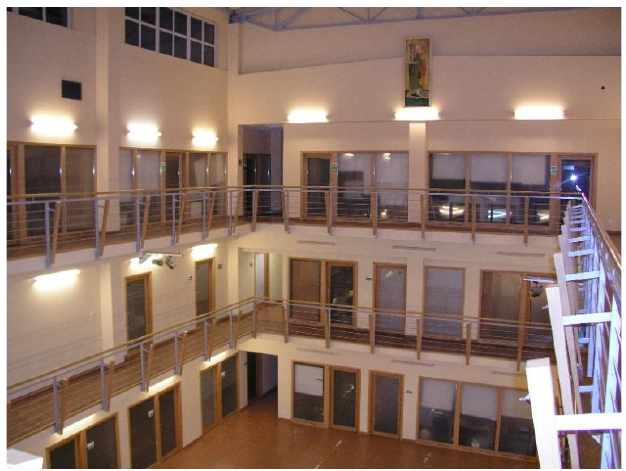
Figure 2. A guildhall in LW Bogdanka S.A. Source: photo provided by LWB.